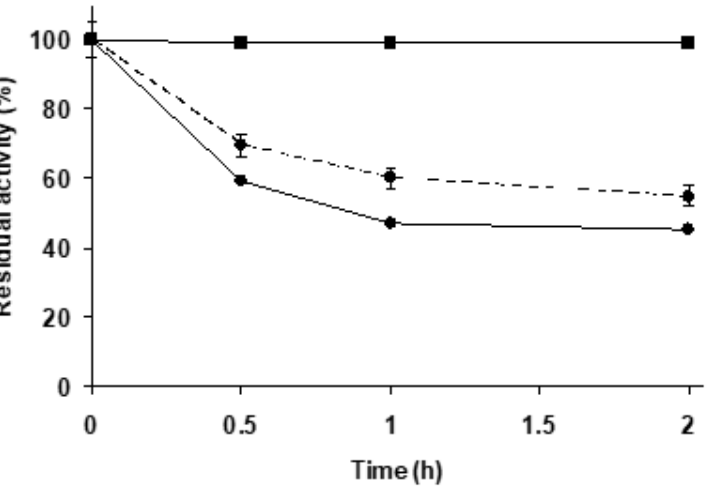
Figure 1. Immobilization course of TLL over agarose C8 beads (solid line) and Purolite C 18 (pointed line) beads offering 20 mg of enzyme per g of support (10 mL of 2 mg enzyme/mL per g of support). Squares: reference (the enzyme under the same conditions of the immobilization suspension but using inert agarose beads) and circles: supernatant. Other specifications are described in Methods.